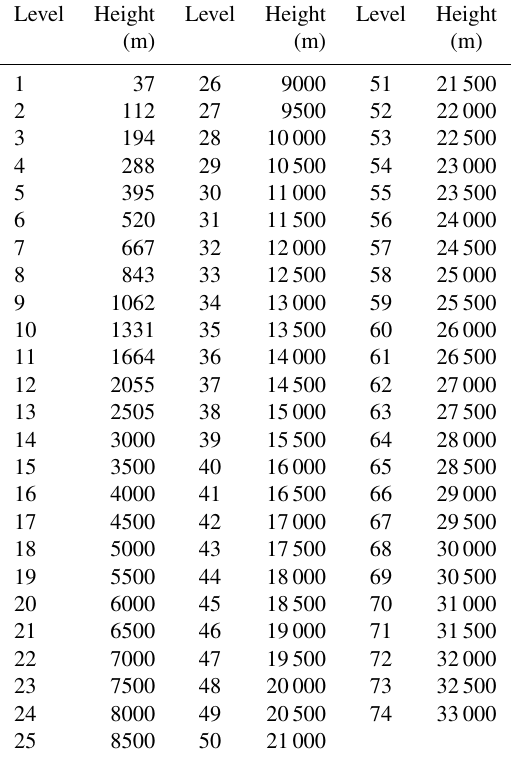
Table 3. CRM vertical grid for scalar